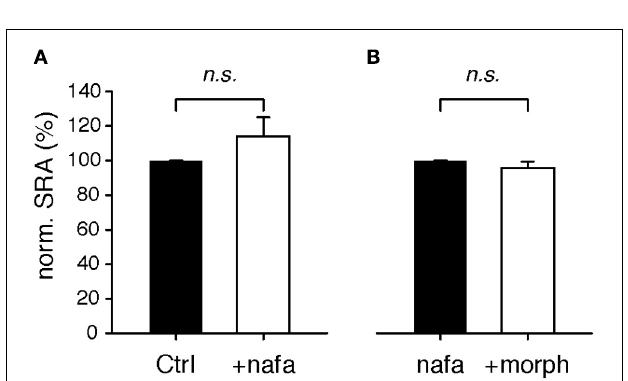
FIGURE 5 | Modulation of spinal reflex amplitudes (SRAs) by the D3-receptor preferring antagonist, nafadotride. (A) In the isolated WT spinal cord, bath-application of nafadotride led to slight, albeit insignificant increase in SRAs ( n = 8). (B) In the presence of nafadotride, additional application of 1 μ M morphine failed to exert any modulatory action on SRAs ( n = 5). additionally bath-applying morphine ( Figure 5B ).